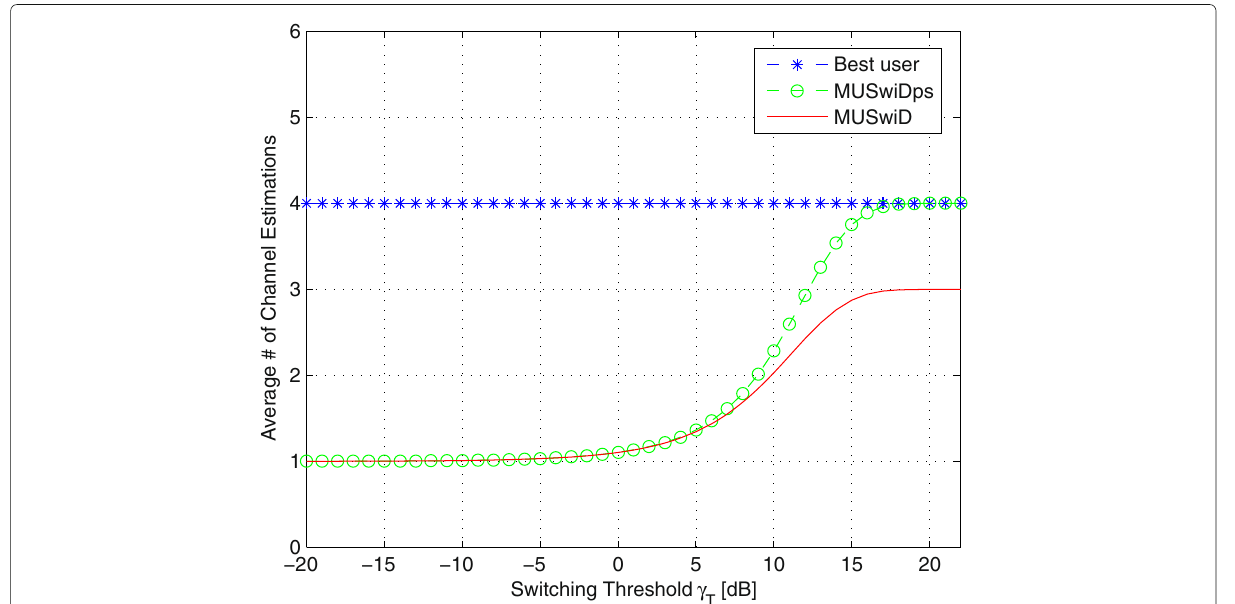
Fig. 11 Average number of channel estimations of the MUSwiD and MUSwiDps user selection schemes in comparison with the best-user or opportunistic user selection scheme with K = 4 and an average power/user path = 10 dB